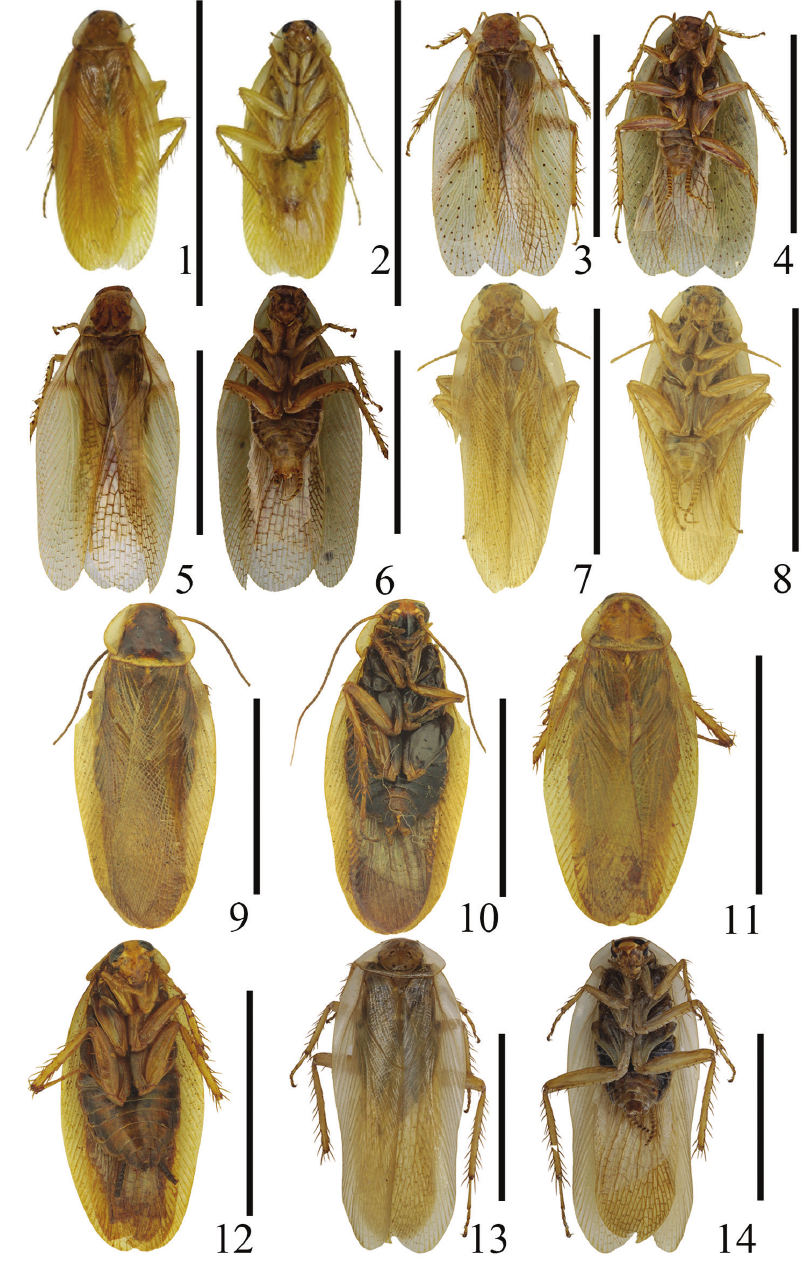
Figures 1–14. 1–2 Balta crena sp. n., male: holotype 1 dorsal view 2 ventral view 3–4 Balta maculata sp. n., male: holotype 3 dorsal view 4 ventral view 5–6 Balta tangi sp. n., male: holotype 5 dorsal view 6 ventral view 7–8 Balta yaoi sp. n., male: holotype 7 dorsal view 8 ventral view 9–10 Balta hwangorum Bey-Bienko, 1958, male 9 dorsal view 10 ventral view 11–12 Balta nodigera (Bey-Bienko, 1958) comb. n., male 11 dorsal view 12 ventral view 13–14 Balta valida (Bey-Bienko, 1958), comb. n., male 13 dorsal view 14 ventral